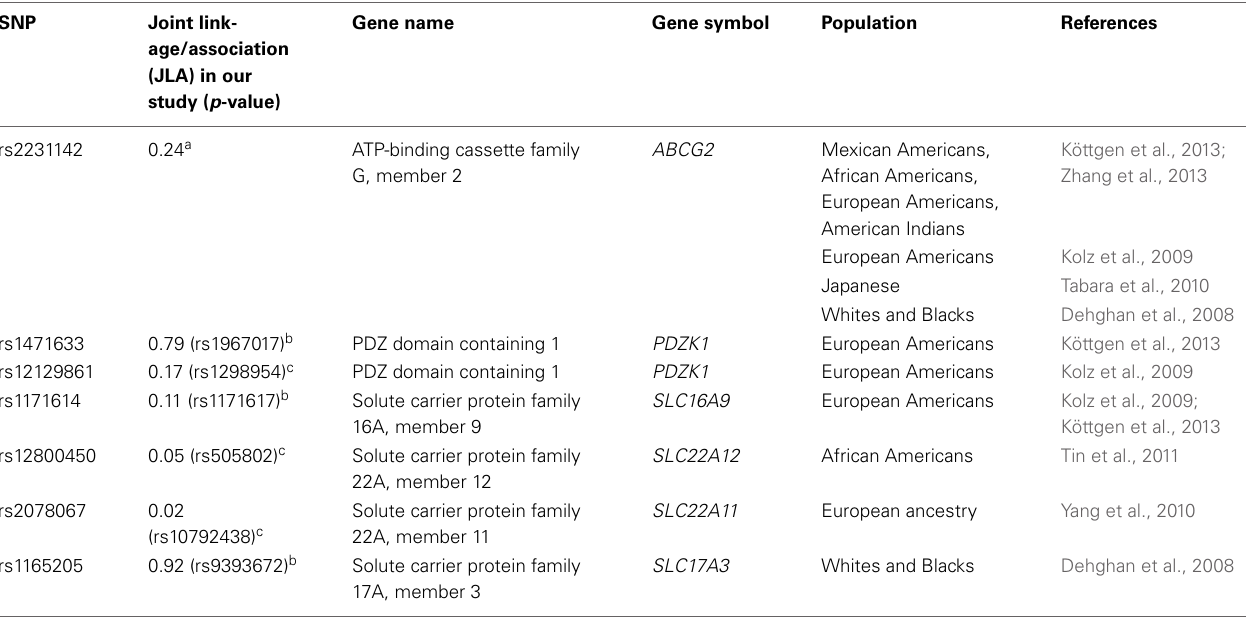
Table 4 | Previously reported association of serum uric acid levels with genes other than SLC2A9